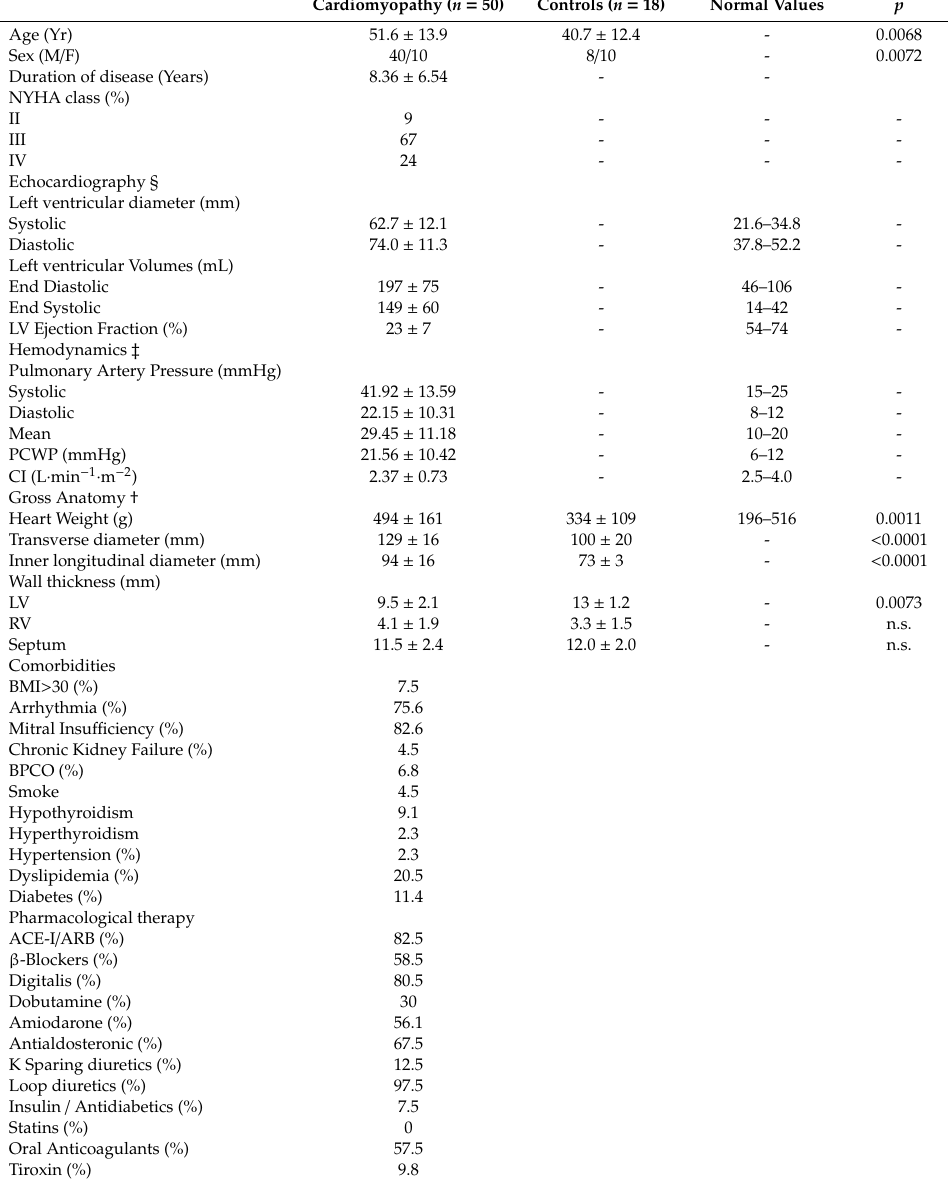
Table 1. Clinical, demographic, and anatomical parameters of the patients whose hearts were included in the histology